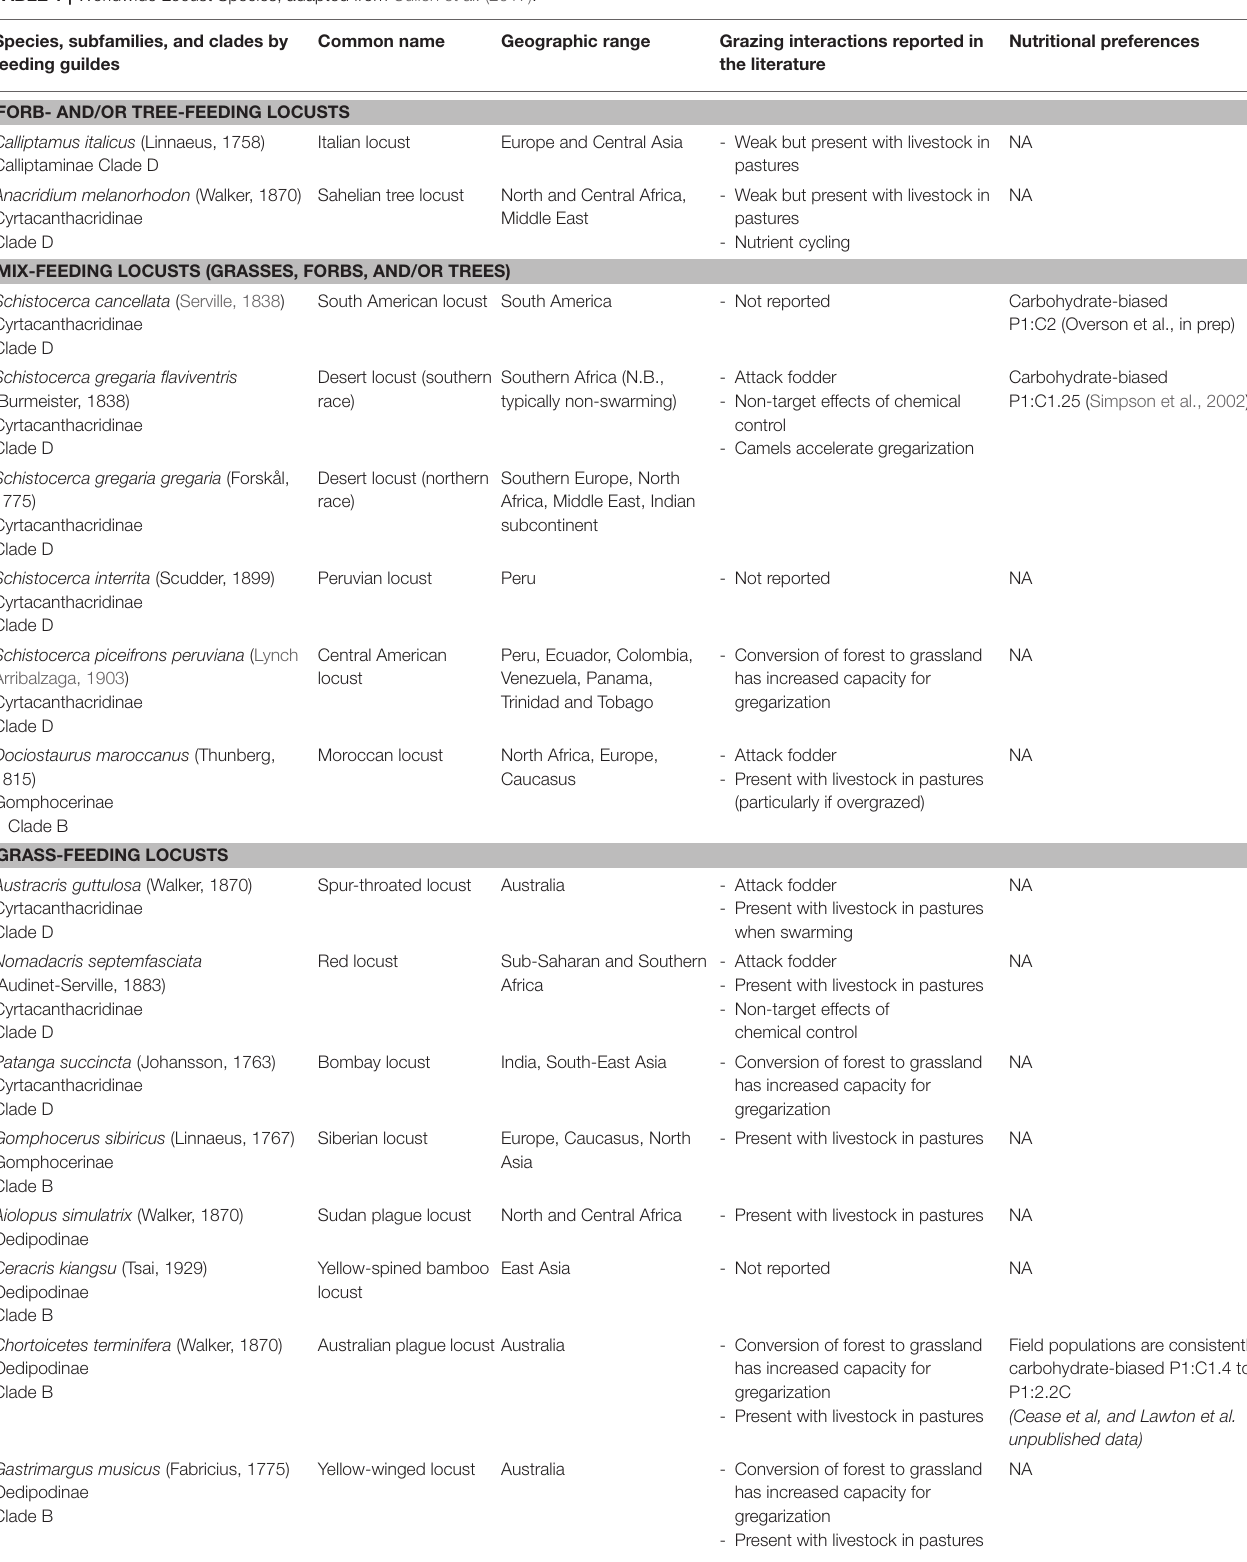
TABLE 1 | Worldwide Locust Species, adapted from Cullen et al.